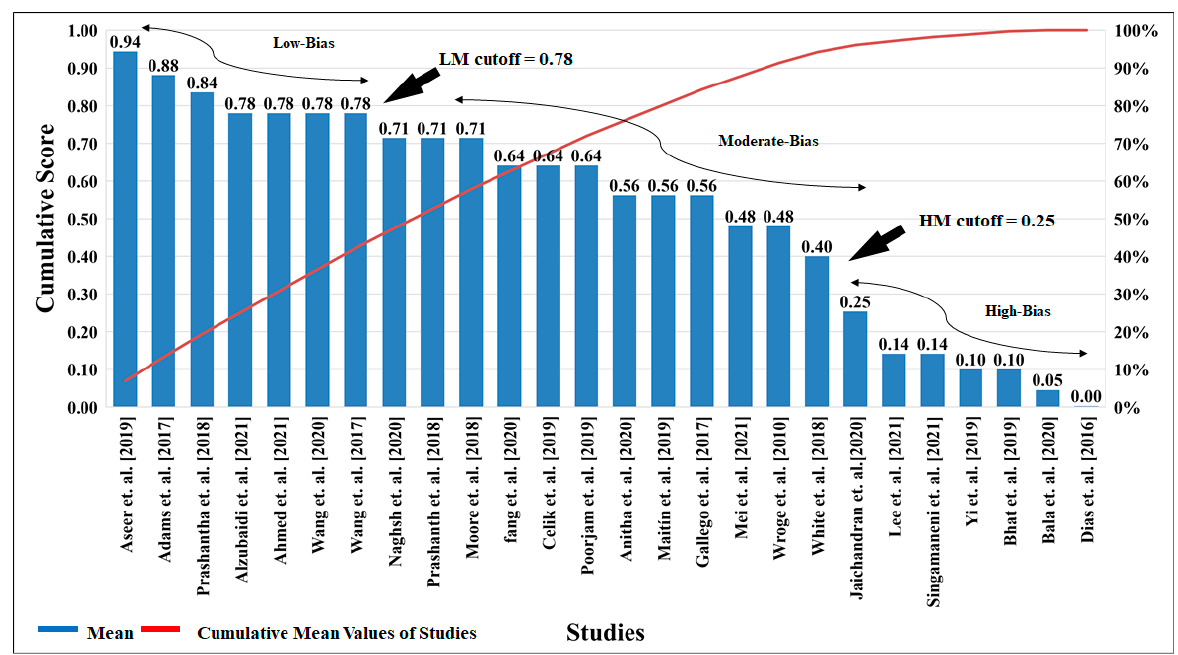
Figure 11. The cumulative cutoff score for evaluation for the selected studies. (LM: Low-Moderate, MH: High-Moderate).